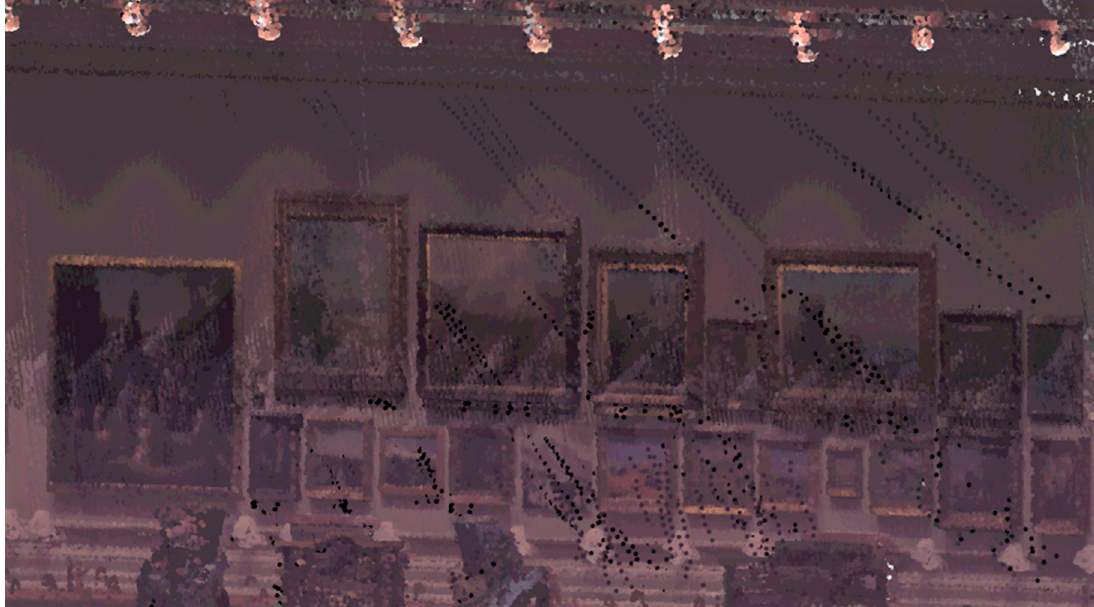
Figure 4. Inside the Long Gallery of Nottingham Castle.